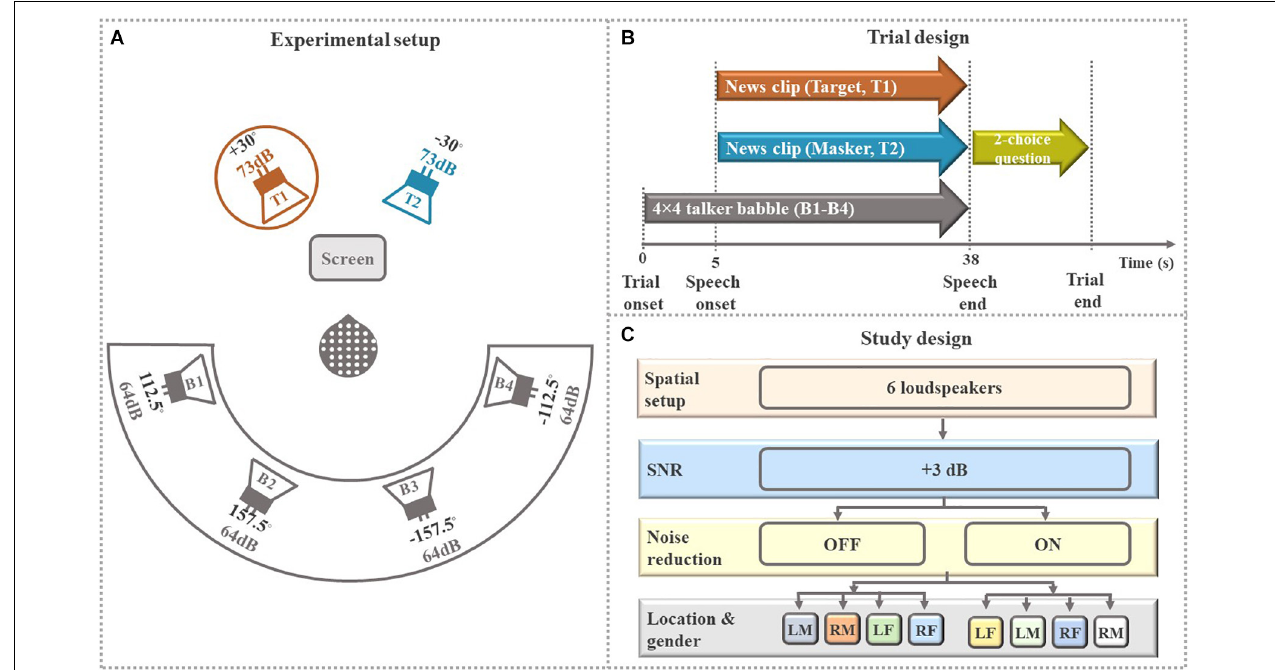
FIGURE 2 | Overall study design. (A) Schematic illustrations of the experimental setup. EEG data were recorded from participants who were asked to selectively attend to one of two simultaneous speech stimuli (talkers T1, T2) coming from two loudspeakers positioned ± 30 ◦ to the left or right of the center. Speech stimuli were presented at an average intensity of 73 dB SPL each in the presence of 16-talker (4 × 4 talker) babble noise (B1-B4) coming from four rear loudspeakers positioned ± 112.5 ◦ and ± 157.5 ◦ to the left or right at an average intensity of 64 dB SPL each. Stimuli T1 and T2 were news clips (continuous speech) uttered by a male and a female talker. The circle around talker T1 shows that the participant in this trial was instructed to attend to the talker T1 and ignore the contralateral talker T2 and 16-talker babble noise (B1-B4). The participants were comfortably seated and instructed to fixate their eye-gaze at the computer screen during sound presentation. (B) Schematic illustration of the trial sequences. (C) Schematic illustration of the study design. The two conditions “ + 3 dB OFF” and “ + 3 dB ON” consisted of 20 trials each, divided into four sub-block of five randomized consecutive trials with target talker being “left mail (LM),” “right male (RM),” “left female (LF),” and “right female (RF).” The presentation order of these four subconditions was counterbalanced across participants for each